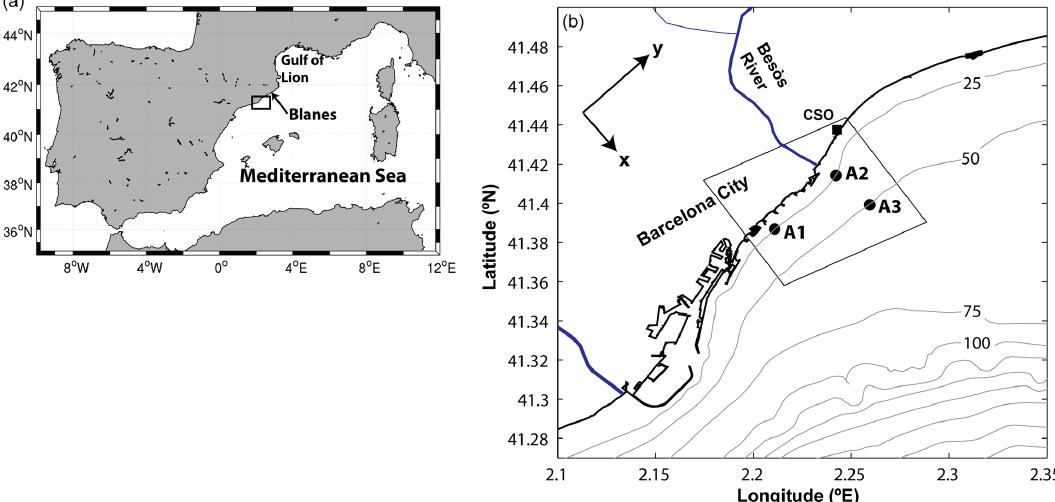
Figure 1. Map of the western Mediterranean Sea with the study area (a) . (b) Shows the bathymetry of a portion of the Catalan shelf (isobaths every 25m) with the locations of the ADCP sensors (A1, A2 and A3). A directional wave buoy was placed at A3. The square marker shows the Coastal Station Observatory (CSO) where the wind data were recorded. (b) Includes the numerical model domain used to propagate the wave conditions into A2 (black rectangle); the reference system adopted for the momentum balance is also